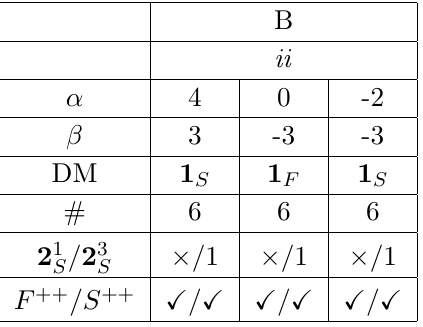
Table 16. The same as in table 10 for diagram 2.g of (cid:12)gure 2.